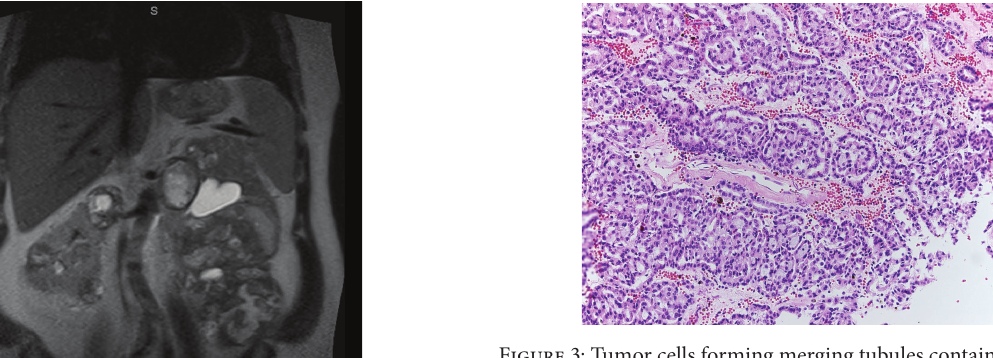
Figure 3: Tumor cells forming merging tubules containing mucin.